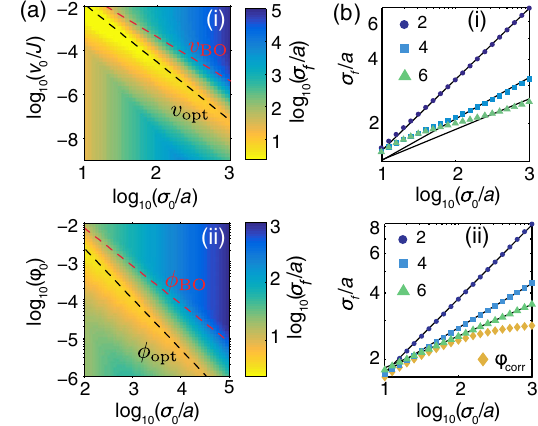
FIG. 3. (a) Final width σ as a function of initial width σ 0 and f (i) potential strength v 0 or (ii) phase ϕ 0 for the (i) thick and (ii) thin lens setup. Dephasing due to the nonquadratic dispersion relation σ ϕ ϕ σ starts to dominate at v 0 ¼ v 0 Þ and 0 ¼ 0 Þ (black opt ð opt ð σ dashed line) while Bloch oscillations start at v 0 ¼ v 0 Þ and BO ð ϕ ϕ σ 0 ¼ 0 Þ (red dashed line) for thick and thin lenses, respec- BO ð tively. (b) Minimum final width σ for the optimized lens strength f as a function of initial width for (i) thick and (ii) thin lens setup. Dark blue dots, light blue squares, and green triangles correspond to the numerically obtained final width for a quadratic, quartic, and sixth-order potential, respectively. The black lines are a guide to the eye, showing the respective scalings of Eq.